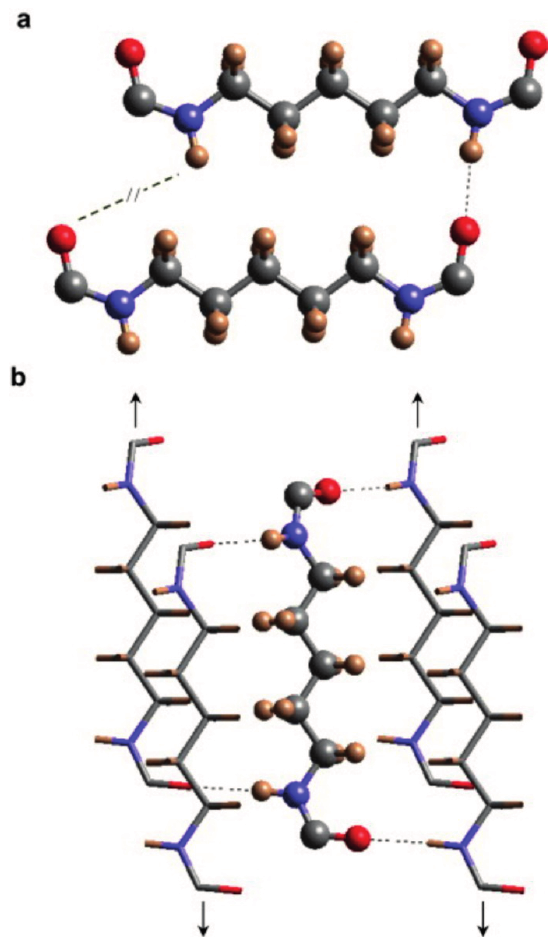
Figure 8. Establishment of hydrogen bonds between Nylon-56 molecular chains, ( a ) scheme of the unfavourable hydrogen-bond geometry between odd diamide units of Nylon-56 molecular chains with an all trans conformation and ( b ) scheme of the establishment of hydrogen bonds along two directions when consecutive amide planes of a molecular chain slightly rotate in opposite directions from the plane defined by the methylene carbon atoms (nitrogen, blue; oxygen, red; carbon, gray; hydrogen, brown), originally published in